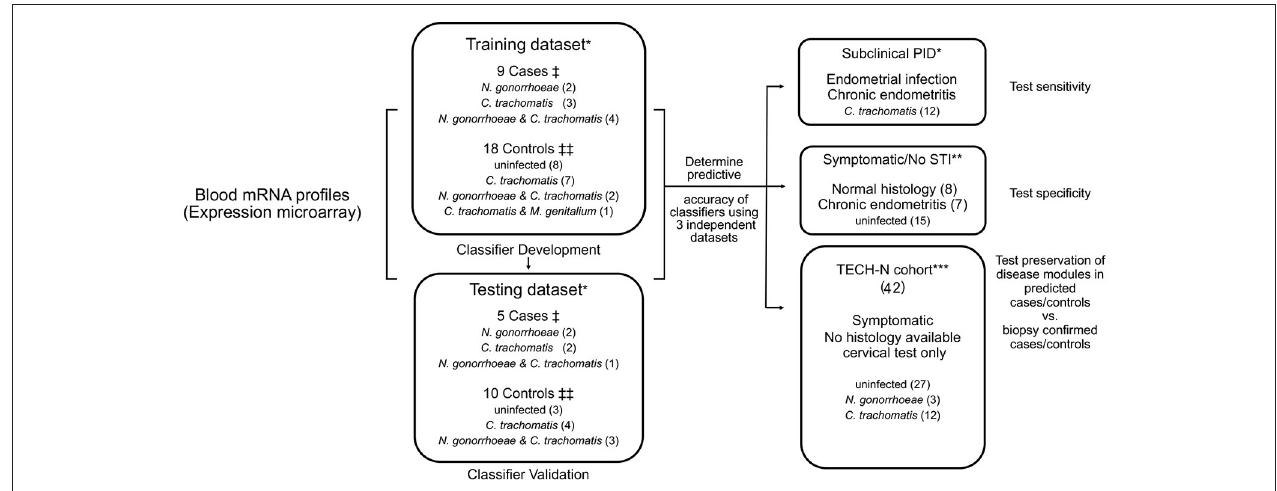
FIGURE 1 | Diagram of study organization. Blood transcriptional mRNA profiles from cases and controls were analyzed in a training dataset. Identified classifier genes were subsequently validated in an independent testing dataset. The classifier genes were also evaluated in three additional independent patient datasets for sensitivity, specificity, and disease module preservation, respectively. † Cases: women with symptoms consistent with PID and with biopsy confirmed endometrial STI with N. gonorrhoeae and/or C. trachomatis and/or M. genitalium and endometritis. ‡‡ Controls: asymptomatic women who were uninfected or infected at the cervix only, with no endometrial inflammation. *Participants recruited from TRAC cohort. **Participants recruited from ACE cohort. ***Participants recruited from TECH-N cohort comprised women with symptoms of PID who had cervical microbiology determined but lacked endometrial data.